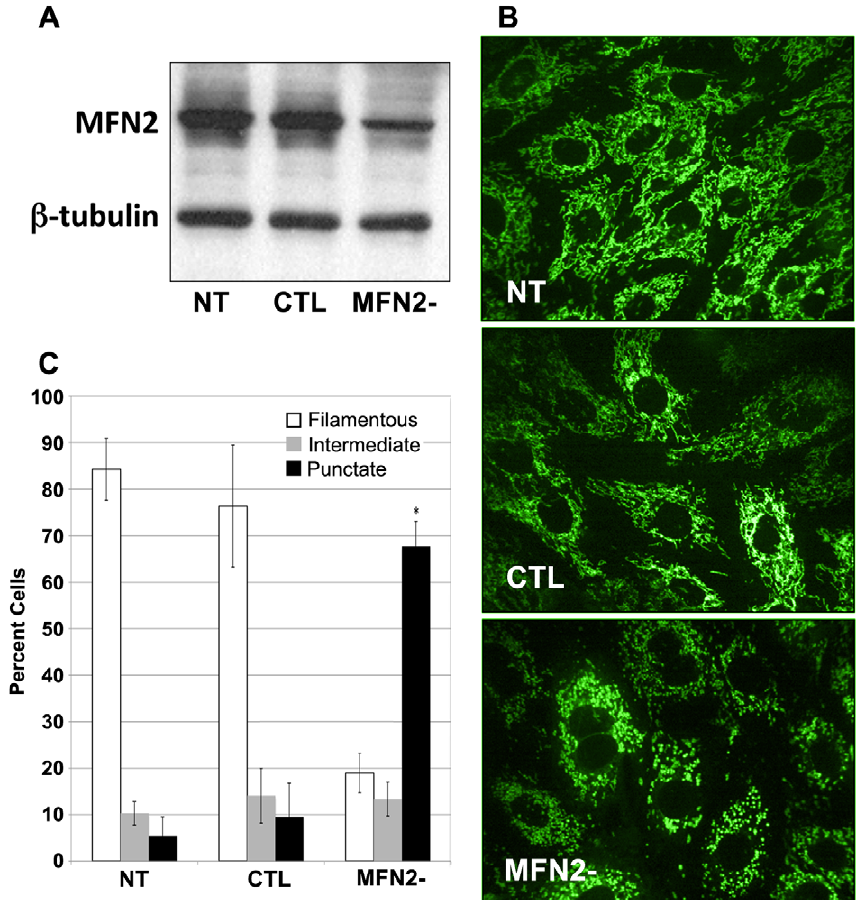
Figure 5. MFN2 deficiency causes fragmentation of mitochondria invitro . ( A ) MFN2 content in MFN2 f/f primary cell cultures treated with Cre adenovirus (MFN2-), empty adenovirus vector (CTL), or no virus (no treatment or ‘‘NT’’). ( B ) Mitochondrial morphology in primary proximal tubule epithelial cell cultures treated as described in (A) above and then stained with MitoTracker Green FM before visualization with a confocal microscope. ( C ) Percentage of primary cells with filamentous, intermediate, or punctate mitochondria assessed by a blinded reviewer after transduction with adenovirus as described above; * P , 0.05 vs. either NT or CTL; data represent the mean and SE of three separate experiments; P , 0.05.